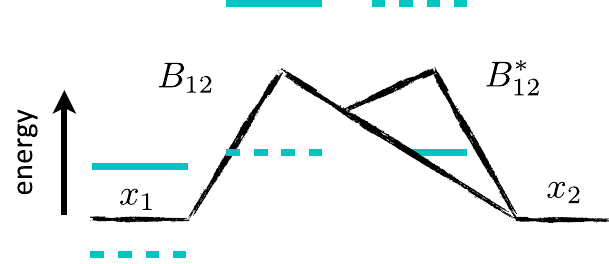
FIG. 4. In the driven scenario depicted schematically here, two states x 1 and x 2 are separated by two different barriers represent- ing two different possible paths for transiting between the states. Because the barriers are driven out of phase with each other, and since β Δ E ≫ 1 and r ≪ 1 = τ ≪ ω , the return probability and average dissipation for transitions from x 2 to x 1 are independent of Δ E , the choice of which should still affect the drift rate from x 2 to x 1 as well as the fluctuations Φ for the pair of paths. As in Fig. 1, the energies of the driven states are drawn at their extremal values in blue, with dashed lines and solid lines, respectively, in phase with each